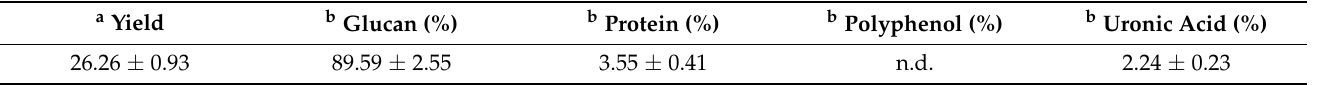
Figure 1. Schematic diagram depicting the preparation of the enriched polysaccharide fraction (EPF) from P. eryngii . Table 3. Chemical characterization of the enriched polysaccharide fraction